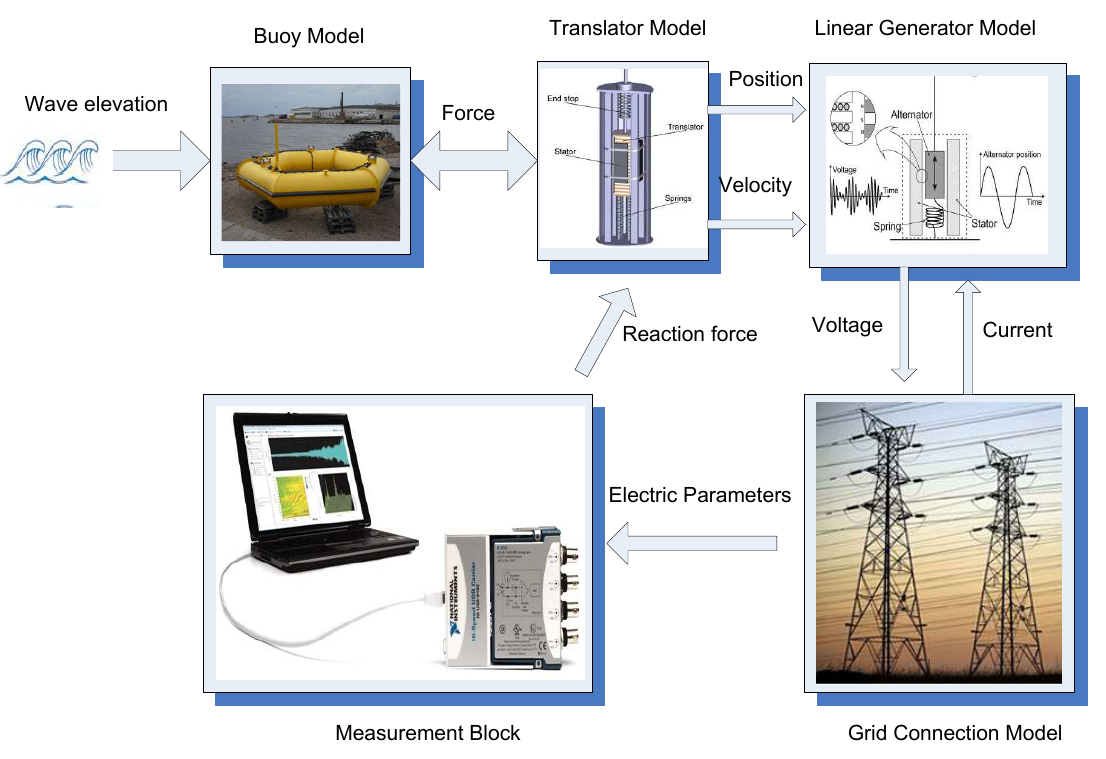
Figure 6. Block diagram of the Simulink model.